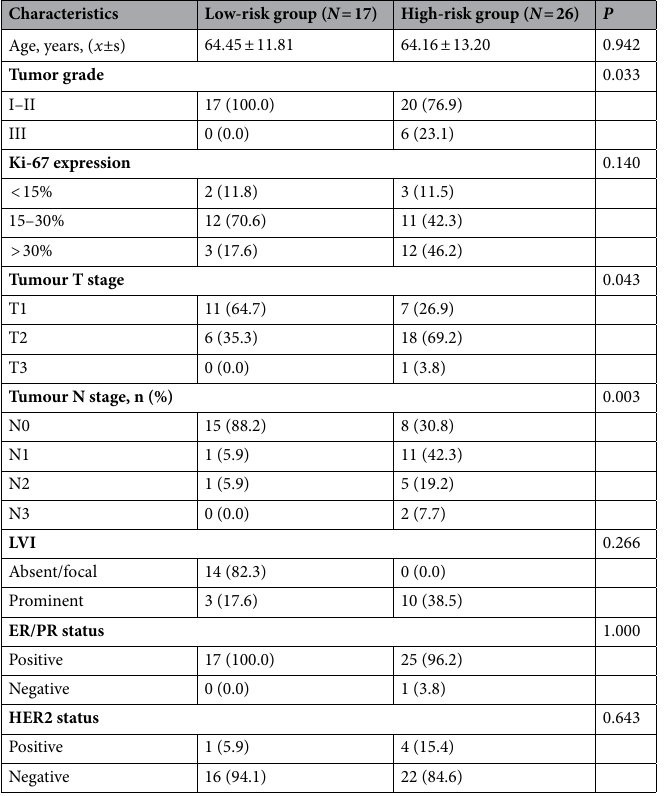
Table 3. Correlation between RI-DR and clinicopathological features, n (%). LVI lymphovascular invasion, ER/PR estrogen receptor/progesterone receptor, HER2 human epidermal growth factor receptor 2, RI-DR recurrence index for distant